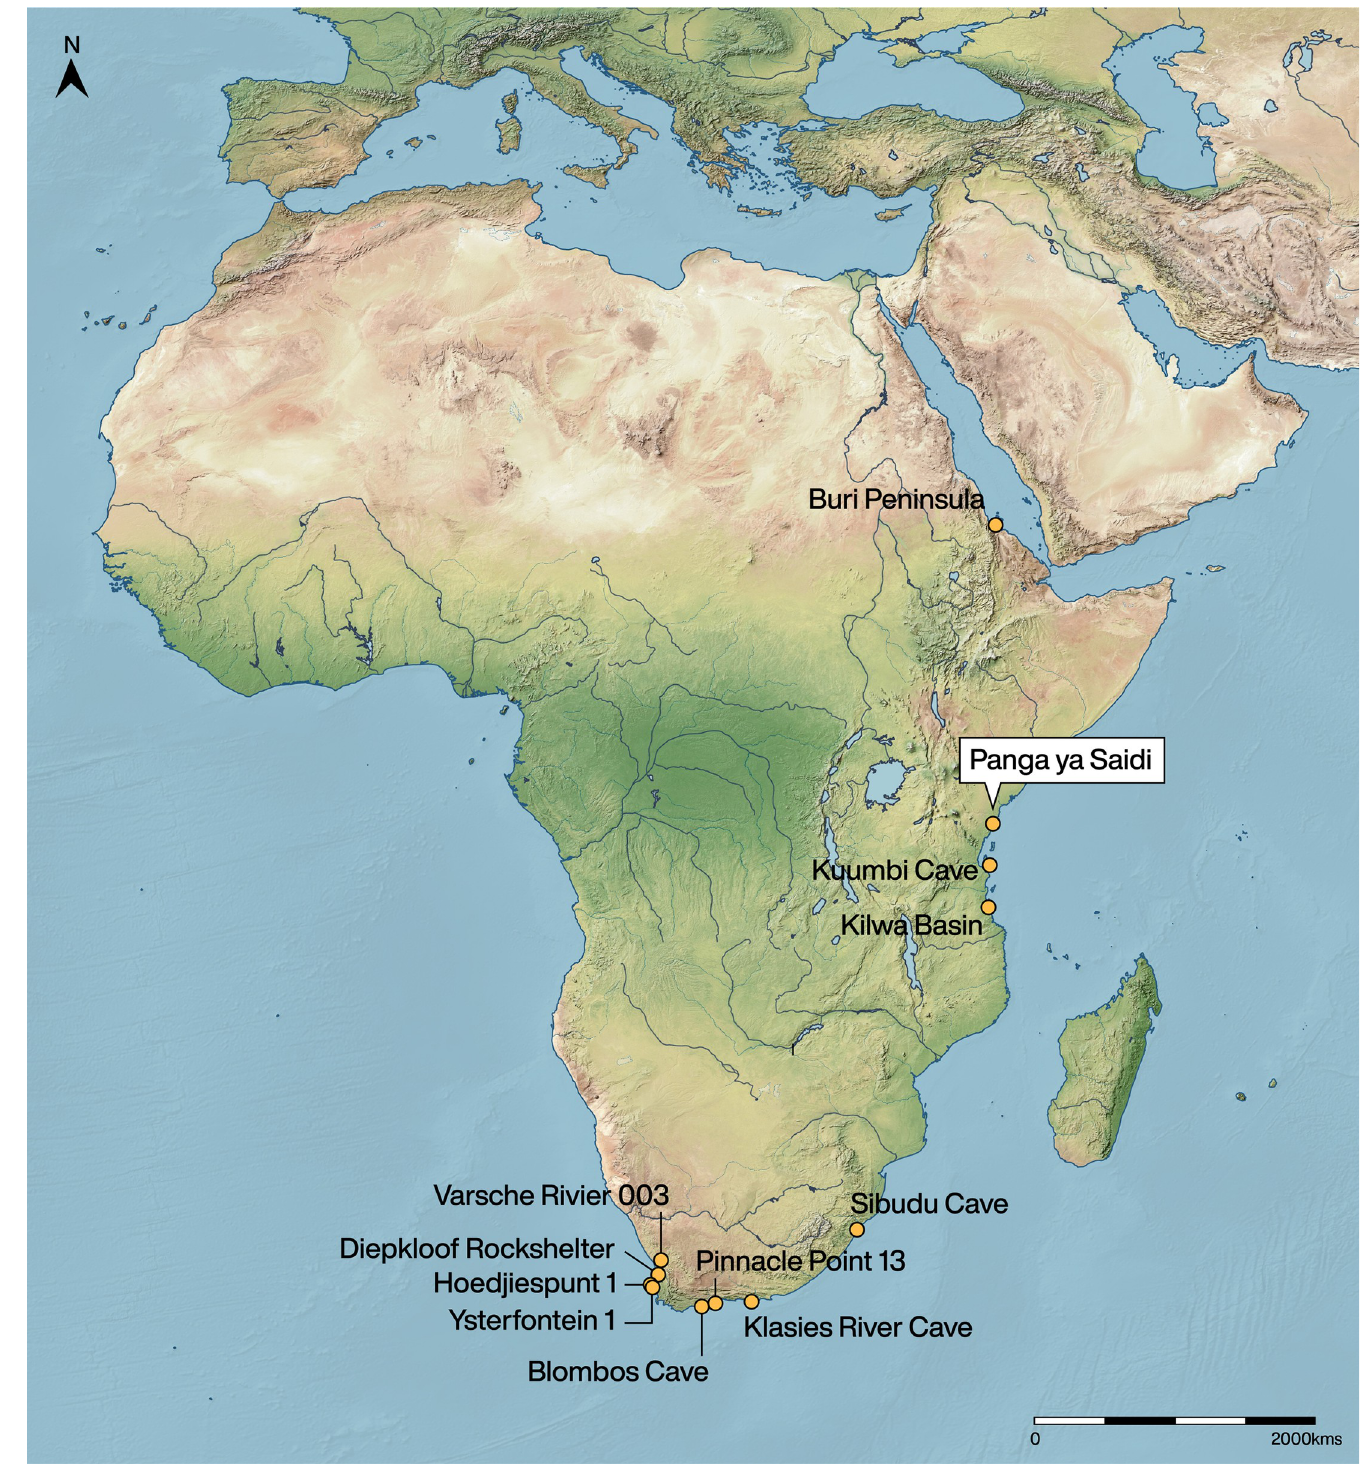
Fig 1. Pleistocene-aged sites with marine resource evidence as mentioned in text. The map was created using QGIS 3.12 (https://qgis.org/en/site/) and uses Natural Earth vector map data (https://www.naturalearthdata.com/downloads/).